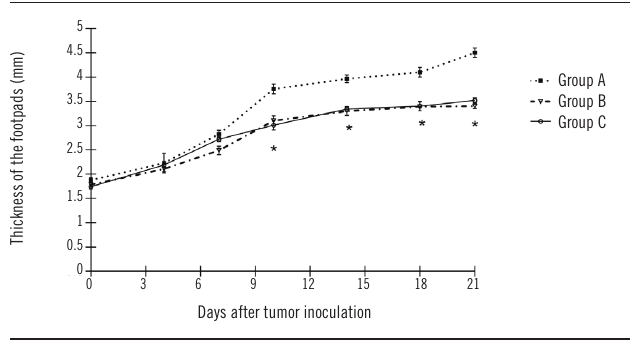
figurE 1 − Tumor growth curve EET growth curve in the footpads of mice for 21 days. Group A: control; group B: beginning of intake prior to tumor inoculation; group C: beginning of intake after tumor inoculation. * p < 0.05 compared to the control group, results expressed as mean and standard deviation with n = 6/group. EET: experimental Ehrlich tumor.